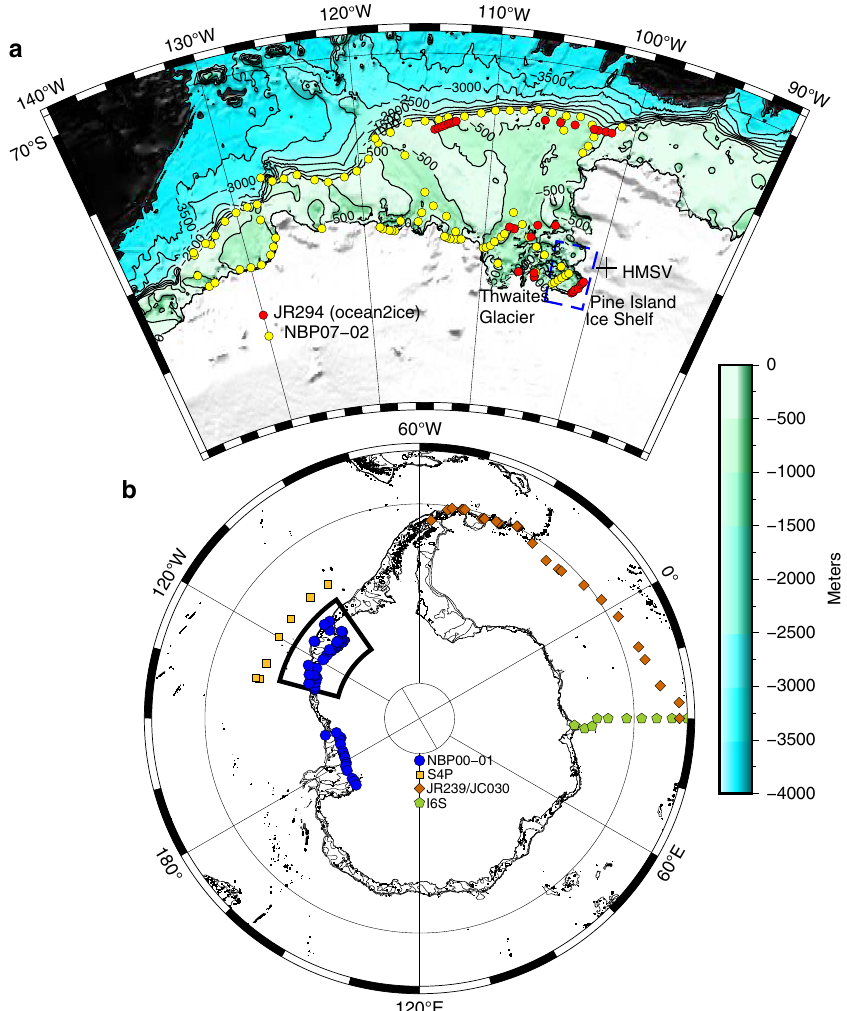
Fig. 1 Map of 3 He measurements around Antarctica. Station locations for helium/neon data used in Fig. 2. a An expanded view of the Amundsen Sea and locations of helium/neon hydrographic stations during NBP07-02 (2007, yellow) and JR294 (2014, red). The “ + ” demarcates the approximate location of the Hudson Mountain Subglacial Volcanoes. The blue dashed line demarcates Pine Island Bay. The mapped region of the Amundsen Sea is indicated by the inset box in b , which depicts the regional and offshore helium isotope hydrography, also included in Fig.